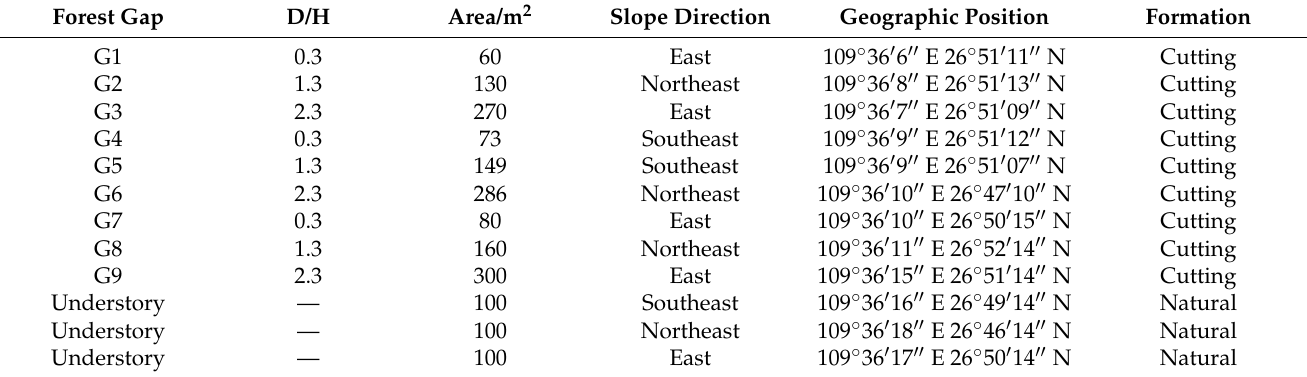
Table 1. General information of the forest gaps and control plots (understory) in this study.